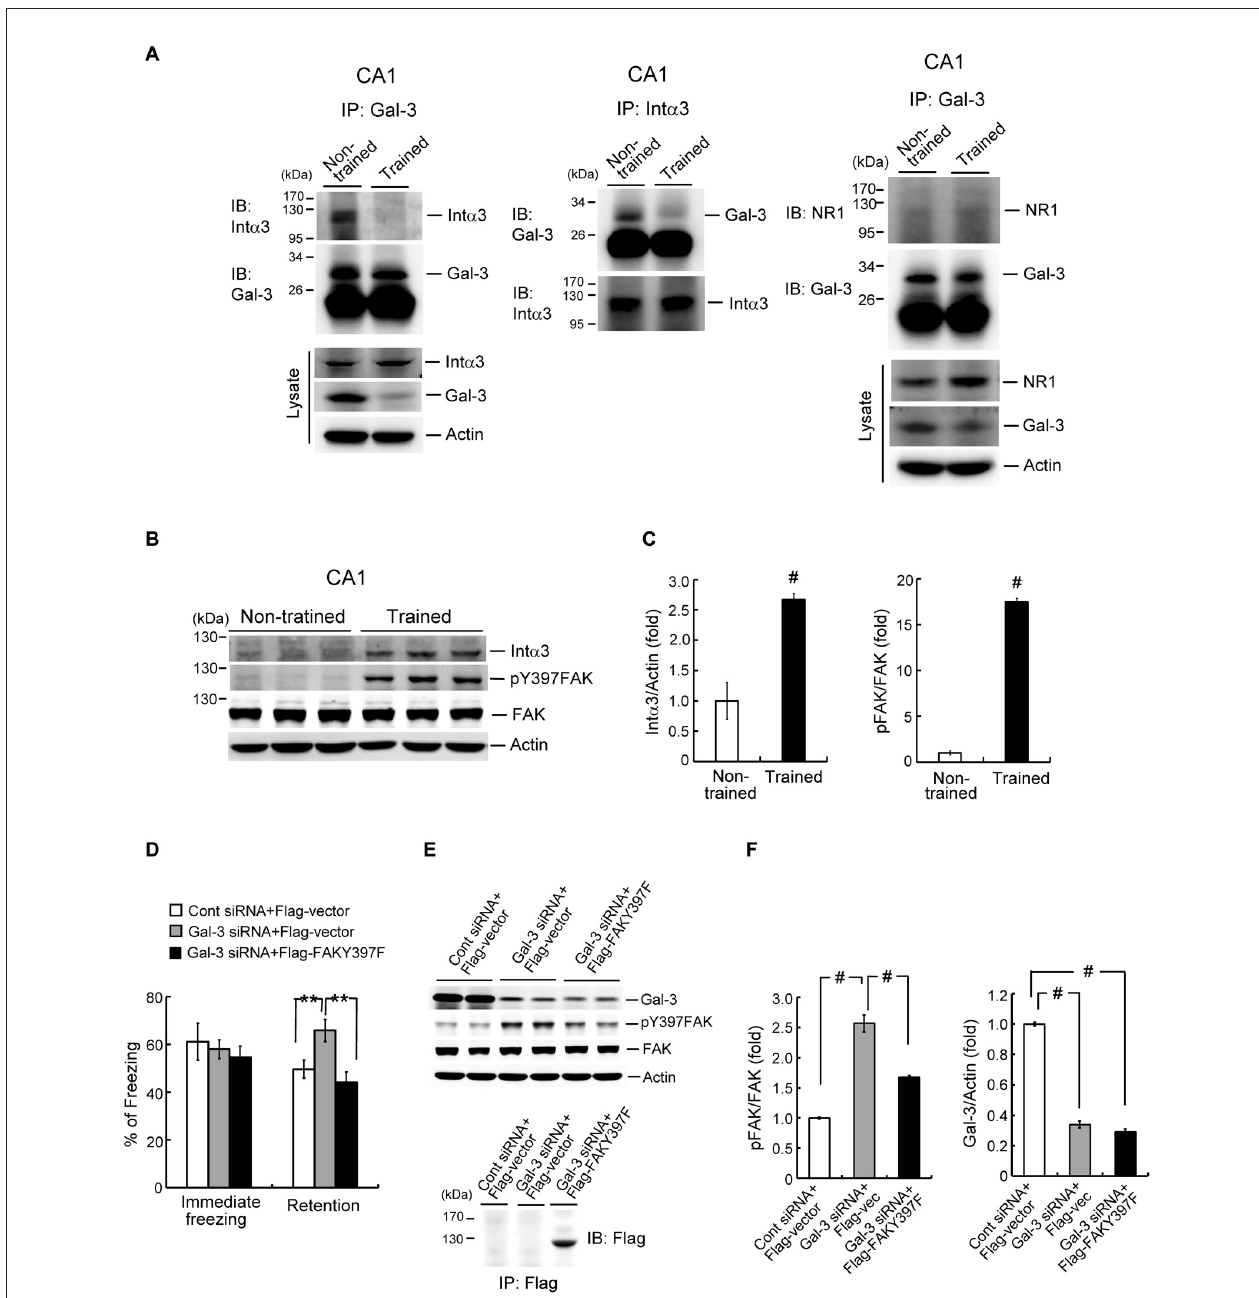
FIGURE 5 | Galectin-3 negatively regulates fear memory through inhibition of integrin α 3-mediated signaling. (A) Left and middle panel, Co-IP experiment showing galectin-3 association with integrin α 3 and vice versa in rat CA1 area. This association is reduced after training (upper panels). Western blot showing the expression of integrin α 3 and galectin-3 in trained and non-trained animals (lower-left panel). Right panel, Co-IP experiment showing that galectin-3 is not associated with NR1 in rat hippocampus, and fear-conditioning training does not apparently alter this relationship. Western blot showing that NR1 expression is increased, but galectin-3 expression is decreased in hippocampal cell lysate of trained animals (lower panel). Experiments are in two repeats. (B) Western blot showing the expression level of integrin α 3 ( t ( 1,10 ) = 5.18, P < 0.001), phospho-focal adhesion kinase (FAK; t ( 1,10 ) = 36, P < 0.001) and FAK in trained and non-trained animals. (C) Quantitative analysis of integrin α 3 and phospho-FAK expression in trained and non-trained animals. N = 6 each group. (D) Immediate freezing response ( F ( 2,24 ) = 0.33, P > 0.05) and retention performance in galectin-3 siRNA + Flag-vector and galectin-3 siRNA + Flag-FAKY397F co-transfected animals ( F ( 2,24 ) = 7.0, P < 0.001; q = 3.81, P = 0.01 comparing the galectin-3 siRNA + Flag-vector group with control siRNA + Flag-vector group; q = 5.08, P < 0.01 comparing the galectin-3 siRNA + Flag-FAKY397F group with galectin-3 siRNA + Flag-vector group). N = 9 each group. (E) Western blot showing the expression level of galectin-3 ( F ( 2,24 ) = 476.38, P < 0.001; q = 36.42 and q = 39.05, respectively; both P < 0.001), phospho-FAK ( F ( 2,24 ) = 87.36, P < 0.001; q = 18.63, P < 0.001 comparing the galectin-3